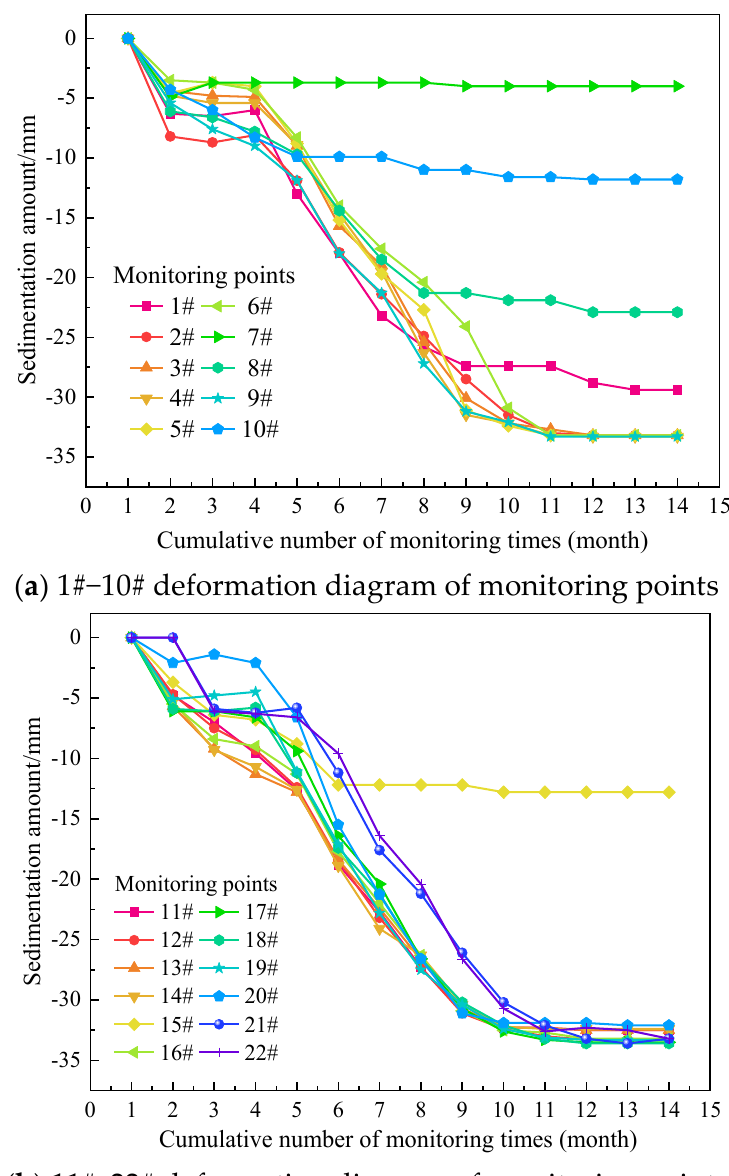
Figure 13. Monitoring results of vertical displacement of supporting structures. By measuring the value obtained by the robot for analysis, the cumulative value of settlement displacement of each monitoring point is 4.00 mm~33.600 mm; according to the requirements of the specification, the vertical displacement early warning value is a cumulative value of 15 mm, and the change rate is 2 mm/d, which can be judged that the incremental change of some monitoring points of all monitoring points in the foundation pit during the entire settlement displacement monitoring period exceeds the allowable warning value range of the specification. After the cumulative deformation value exceeds the scope of the early warning value, the on-site monitoring point is encrypted monitoring, and the on-site inspection is strengthened; the side wall of the foundation pit has not been continuously deformed, and the surrounding cracks have not continued to develop, and the monitoring points with large vertical deformation after analysis are all at the edge road and passage, there are edge loads and vehicle vibrations, and the construction unit